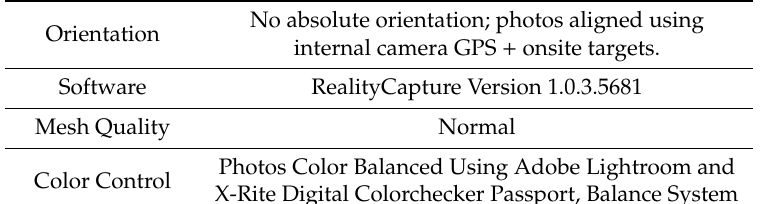
Table A1. Photogrammetry